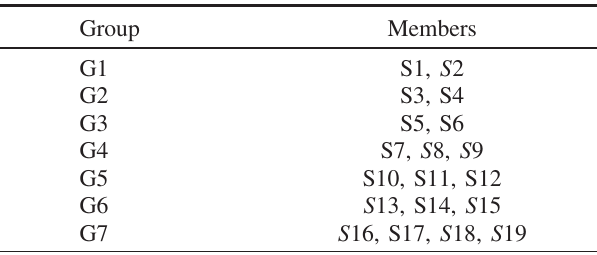
TABLE I. Discussion group composition. Female discussants are presented in